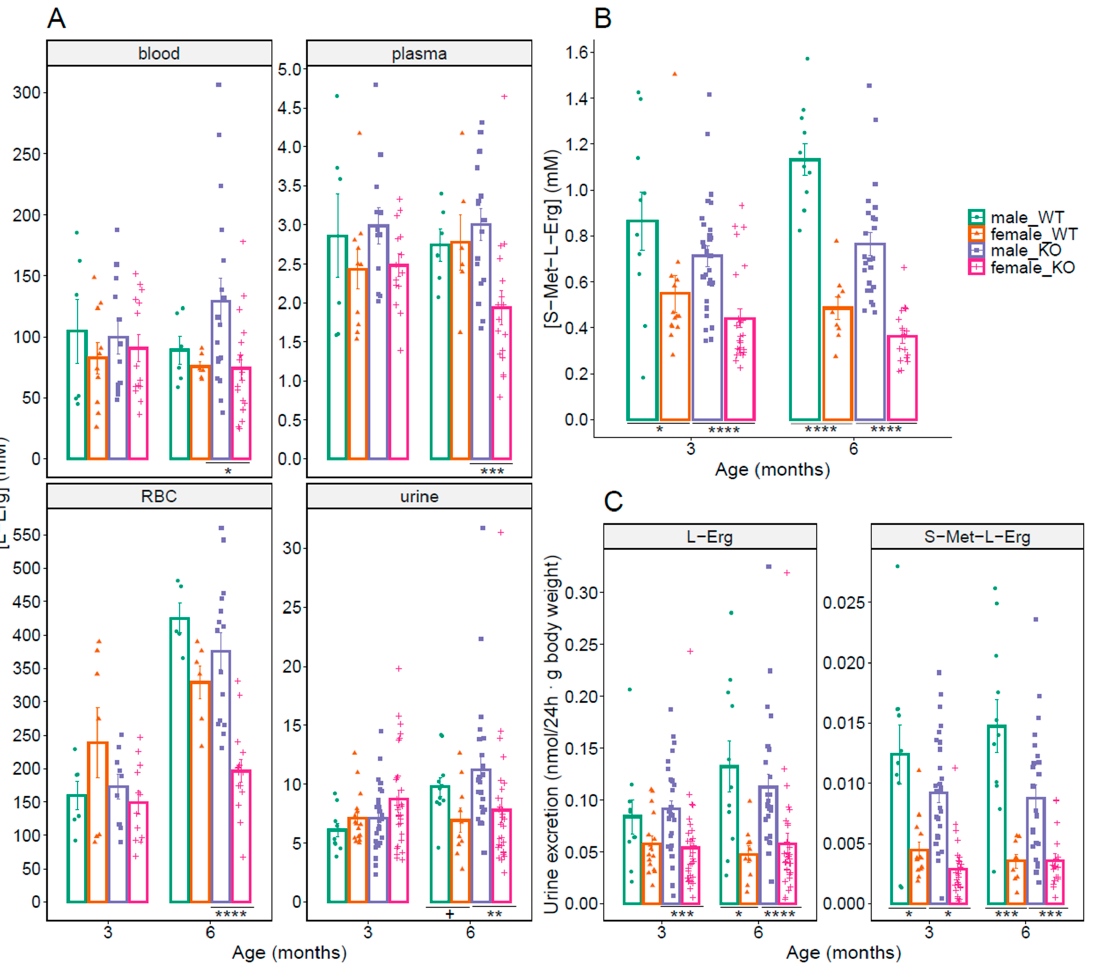
Figure 3. Sex-related differences of L-Erg and S-Met-L-Erg levels in WT and cystinuric ( Slc7a9 − / − ) mice at 3 and 6 months of age. ( A ) L-Erg concentration in blood, plasma, red blood cells (RBC) and 24 h urine in WT and Slc7a9 − / − (KO) male and female mice. ( B ) S-Met-L-Erg concentration in 24 h urine. ( C ) L-Erg and S-Met-L-Erg excretion. Each colored symbol represents a sample (the number of mice per condition ranges from 5 to 31), and the bars indicate the mean ± SEM. Mann-Whitney probability test value is indicated below the bars as +, p ≤ 0.1; and, *, p ≤ 0.05, **, p ≤ 0.01, ***, p ≤ 0.001, ****, p ≤ 0.0001 vs . male mice.